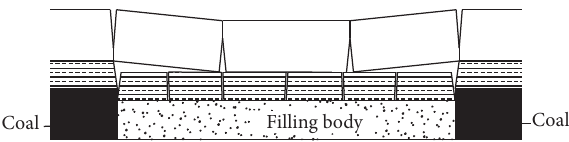
Figure 10: Schematic diagram of main roof rock beam fracture.